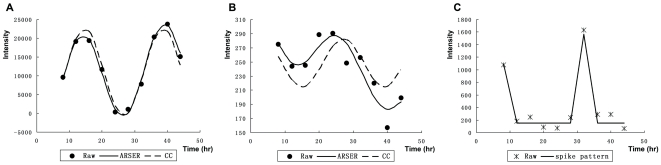
Examples for diurnal probe sets for different pattern identification algorithms.The scatter plot is a raw expression value of probe sets for 8–44 h, with sampling every 4 h; the solid line represents the cosine-curve model with ARSER (AR) simulation; the dash line represent the cosine-curve model with cross-correlation (CC) simulation. A: Os.7890.1.S1_x_at, seedling leaves, replicate sample 1. B: Os.15803.1.S1_at, seedling leaves, replicate sample 2. C: Os.22928.2.S1_at, flag leaves, replicate sample 1